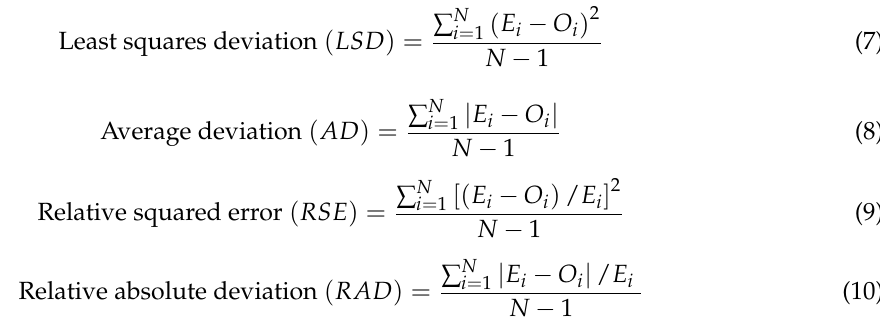
Figure 11. Approximation of the state of health ( SoH )’s linear trend from the driving data.